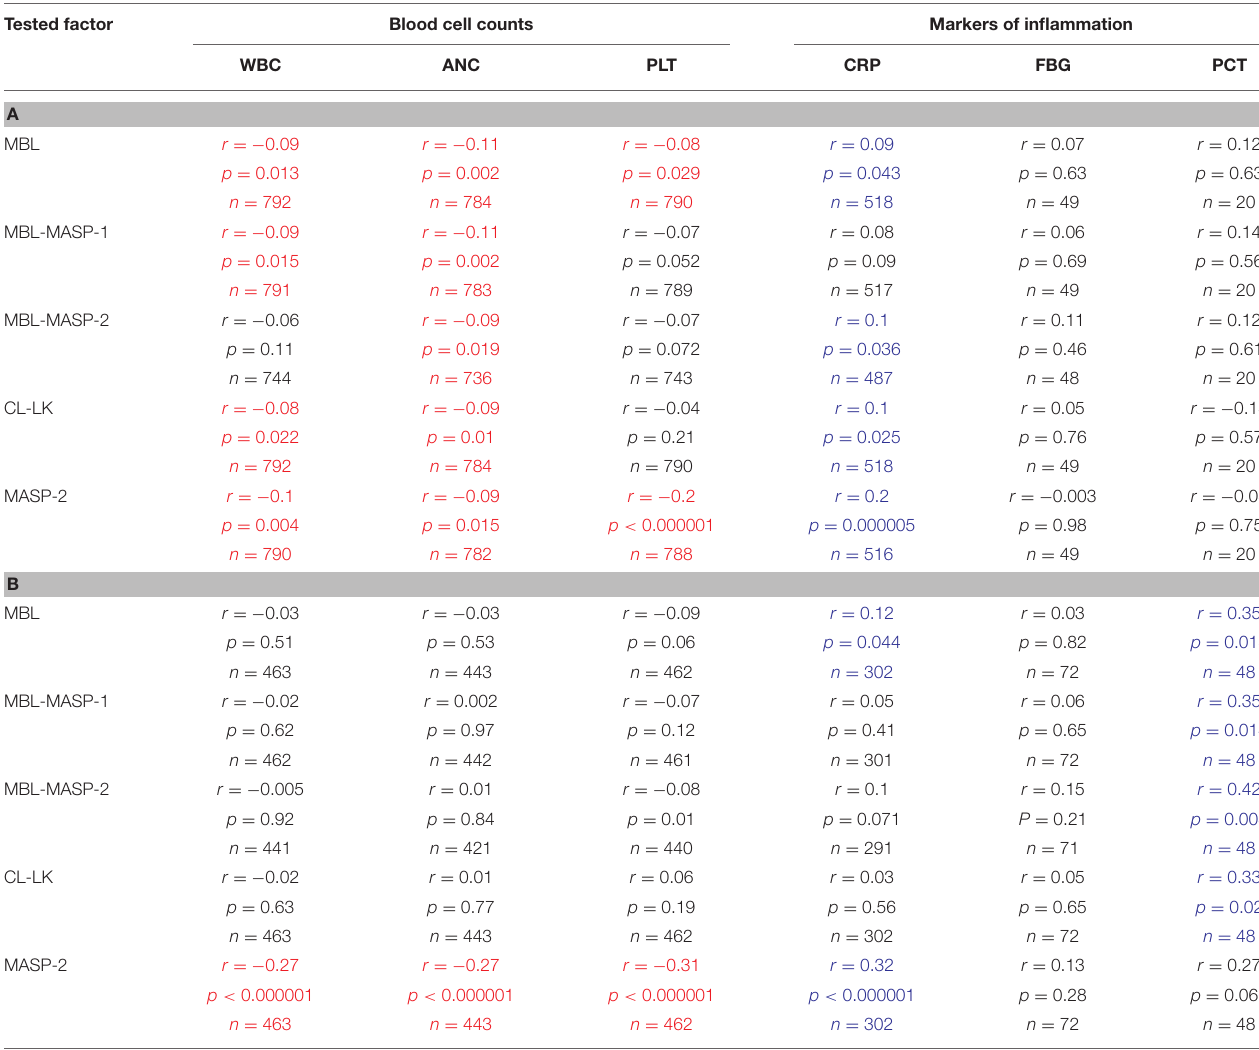
A – patients suffering from multiple myeloma; B – patients suffering from